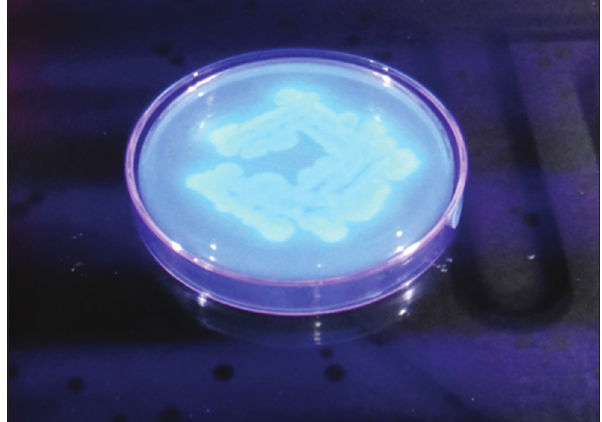
Figure-2: Blue-green fluorescence under ultraviolet light of Pseudomonas aeruginosa